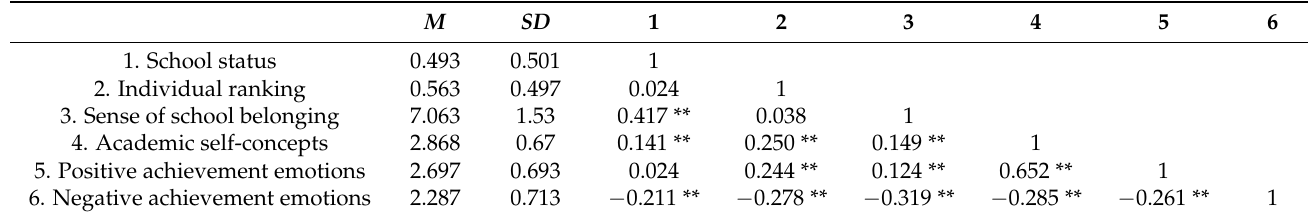
Table 2. Descriptive statistics and Pearson correlation coefficients for the study variables.